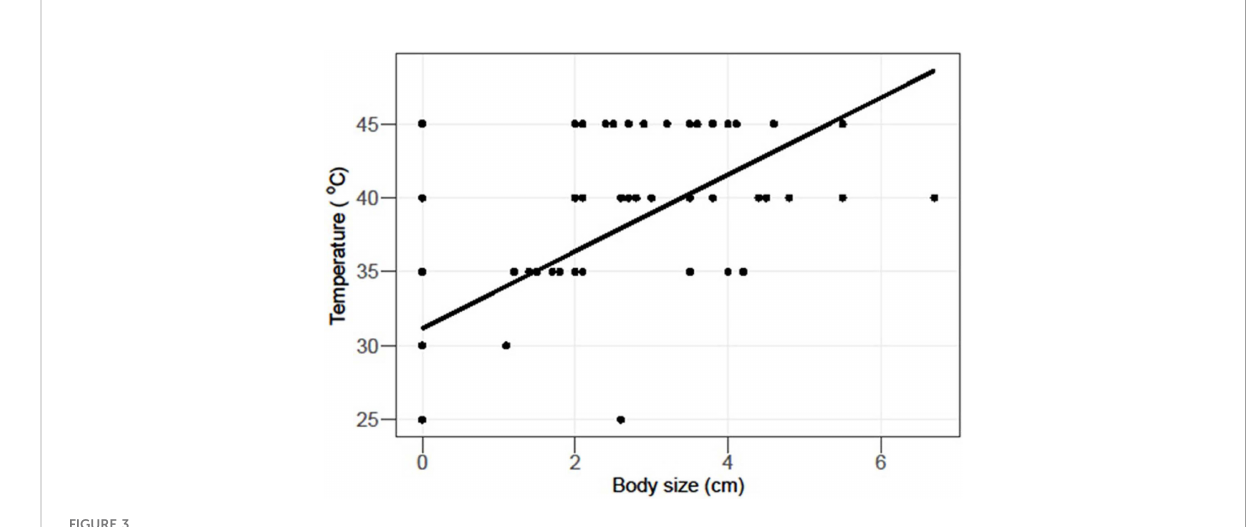
FIGURE 3 Linear regression applied to test LT 50 and body sizes of Nerita albicilla, Tylothias savignyi and Monodonta canalifera . The coef fi cient of correlation ( R ) shows inverse relation between LT 50 and body